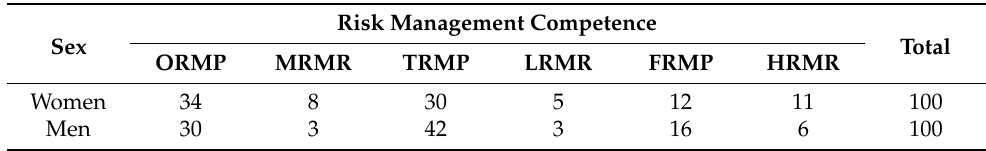
Table 3. Percentage distribution of risk competence according to